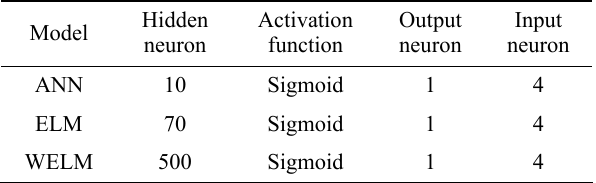
Table 5 ANN, ELM, and WELM model architectures.